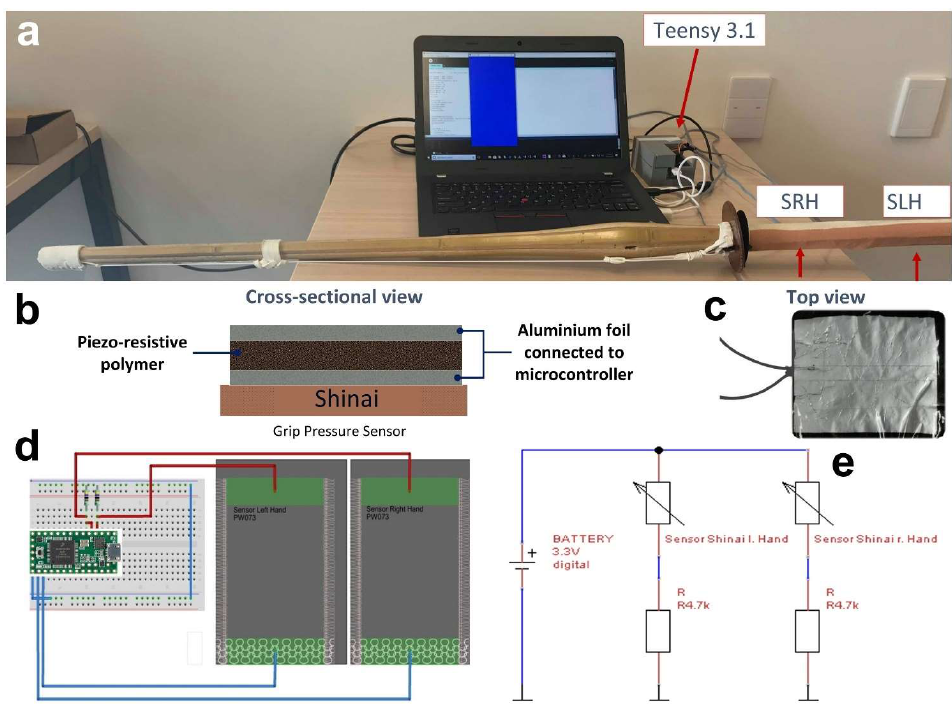
Figure 3. Development of the grip pressure sensor; ( a ) sensor system components; ( b ) schematic cross section of the sensor; ( c ) polymer pressure sensor with top electrode; ( d , e ) circuit diagrams with voltage dividers.